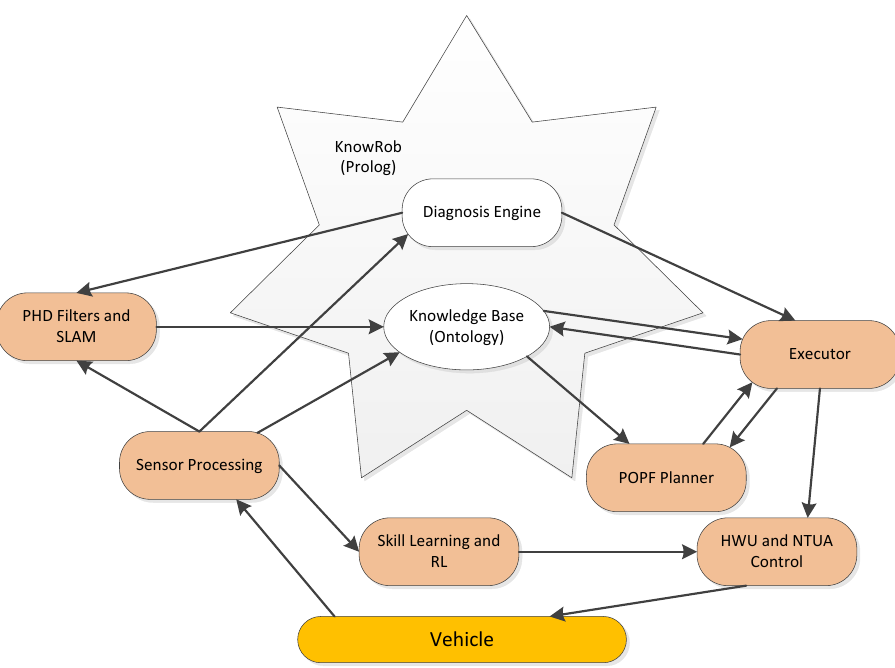
Figure 6. High-level architecture of KnowRob, as described in [37].